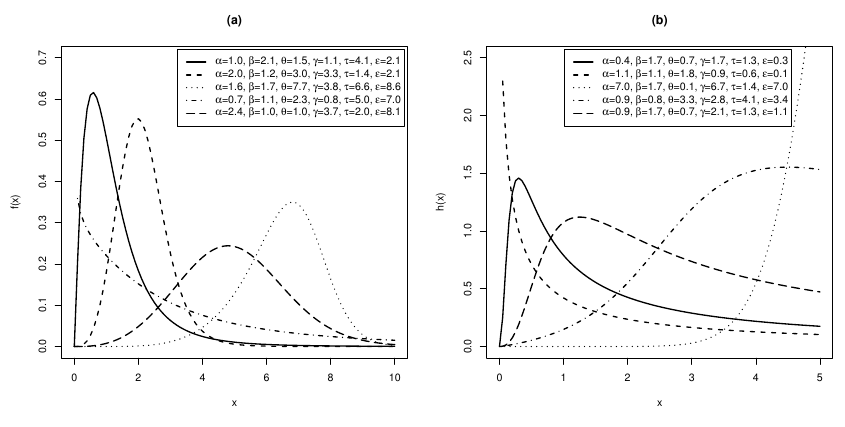
Figure 3 – Plot of the density and hazard functions of EOLxB for some possible parameter